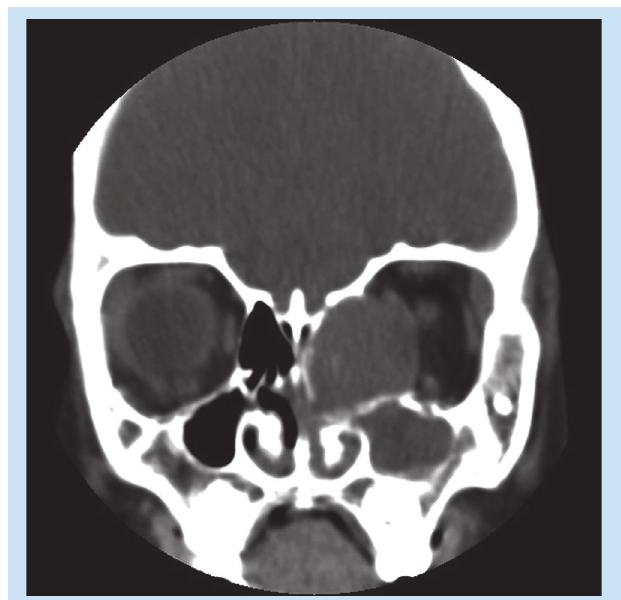
Fig. 2. Coronal CT scan (soft-tissue window) shows minimal rim enhance- ment of the left ethmoid mucocele, with no enhancement of its content — central high-density foci (within the mucocele) are due to inspissated mucus. There is minimal displacement of the left optic nerve and mild left proptosis. There is associated obstruction and opacification of the left maxillary